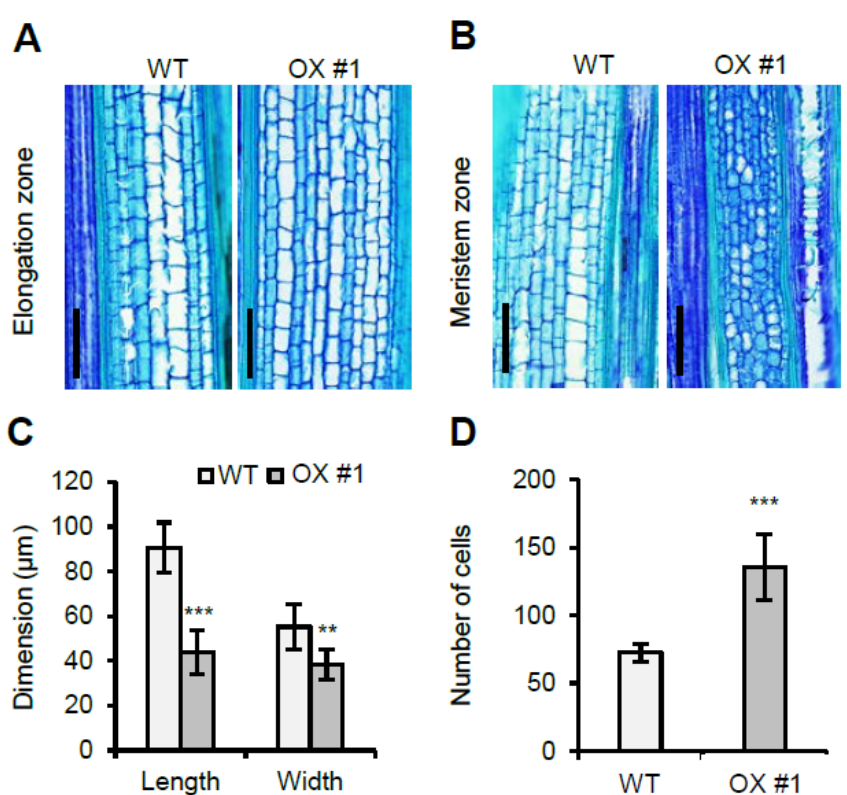
Figure 5. Longitudinal section of the first internode from wild-type (WT) and OsVIL1 overexpression (OX) plants. ( A ) Longitudinal section analyses of the elongation zone from the first internodes in the WT and OsVIL1 OX #1 line at about 149 DAS. Bars = 200 µ m. ( B ) Longitudinal section analyses of the meristem zone from the first internodes at about 149 DAS. Bars = 200 µ m. ( C ) Comparison of cell length and width in the upper 0.5 cm of the cell division region in the first internode of the WT and OsVIL1 OX #1 line, n = 30 cells from three individual plants. ( D ) Comparison of cell numbers. Cells were counted in a sample 0.2-mm 2 area in the meristem region of the internode. The error bars indicate the standard deviations, n = Statistical significance is indicated by *** ( p < 0.001), ** ( p < 0.05).